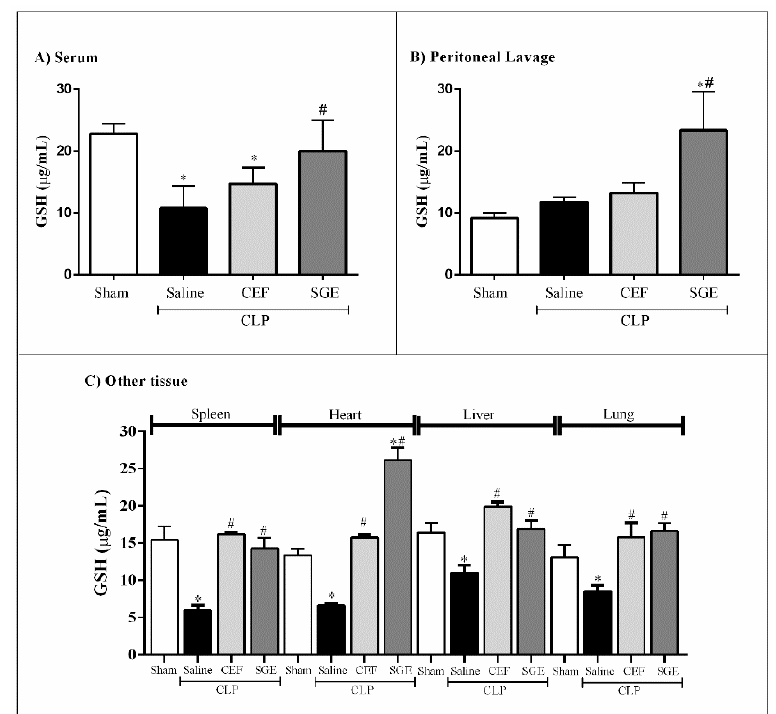
Figure 6. Effect of SGE on GSH levels in septic mice. ( A ) GSH levels in serum 12 h and 24 h after CLP. ( B ) GSH levels in peritoneal cavity 12 h and 24 h after CLP. ( C ) GSH levels in other tissue after 12 h CLP. The results were expressed as the mean ± SD (five animals/group). * p < 0.05 compared to the sham control group; # p < 0.05 compared to saline-pretreated sepsis group. CLP: cecal ligation and puncture; SGE: salivary gland extract; CEF: ceftriaxone; GSH: glutathione.